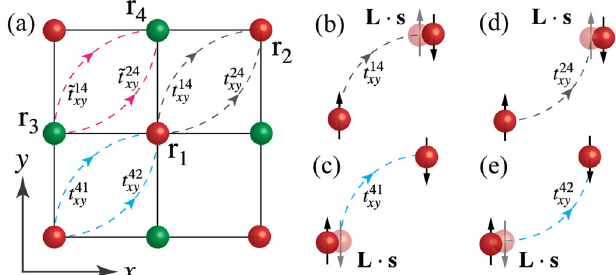
FIG. 12. (a) shows the NN intrasublattice hoppings (dashed lines) between the d and d orbitals in iron-based super- xz=yz xy conductors, with the hopping parameters t mn shown in Table II. i The hoppings in gray and blue occur within the Fe1 sublattice, and the hoppings in magenta occur within the Fe2 sublattice. Notice that the x=y direction in (a) has a difference of π = 4 rotation with the primitive lattice vectors. (b) – (e) show the four second- order processes which can induce the Rashba term λ d † ð r 1 Þ d xy; ↓ ð r 2 Þ in (a). The second-order processes are R xy; ↑ intermediated by the d orbital [the half-transparent red ball xz=yz which represents d , d , d , and d in (b), (c), (d), and xz; ↑ xz; ↓ yz; ↑ yz; ↓ (e), respectively]. The dashed lines in (b) – (e) have the same meaning as those in